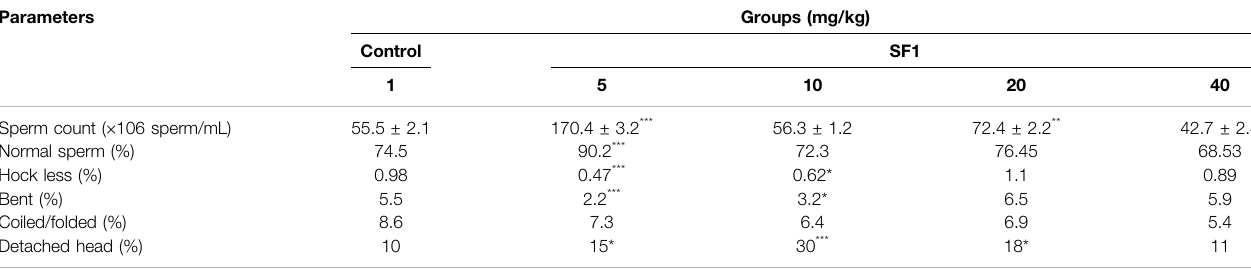
The control used is CMC. Data represented as mean ± SEM (n (cid:1) 5). *p < 0.05, ** p < 0.01 and *** p < 0.001 were given in comparison to the